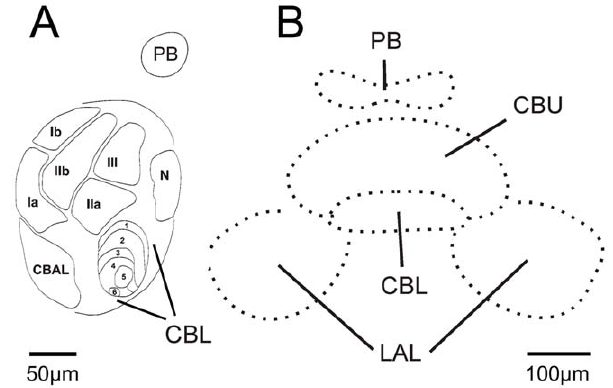
Figure 1. Neuropils of the grasshopper central complex. A: Sagittal section through the upper (CBU) and lower (CBL) division of the central body and one nodulus (N). Left side of the drawing is anterior and top is dorsal with respect to the grasshopper’s body axis. The central body includes fronto-horizontal layers, three layers (layer I– III) plus the central body anterior lip (CBAL) in the upper division and six in the lower division (layer 1–6). The layers I and II of the upper division can both be subdivided into compartments a and b (modified after [18,21]. B: Frontal section through the protocerebral bridge (PB), the upper (CBU) and lower (CBL) division of the central body and the lateral accessory lobes (LAL). Top of the drawing is dorsal and bottom is ventral with respect to the grasshopper’s body